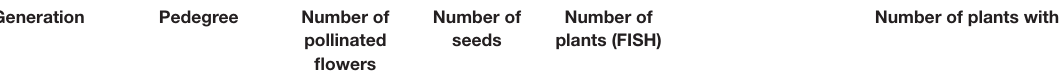
Number of Number of Number of plants with pollinated seeds plants (FISH) flowers U-genome chromosomes S-genome chromosomes